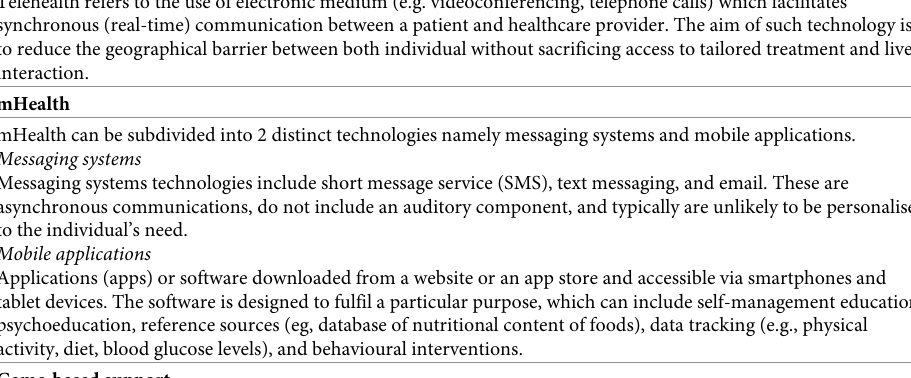
Table 1. Definition of digital health interventions used in this